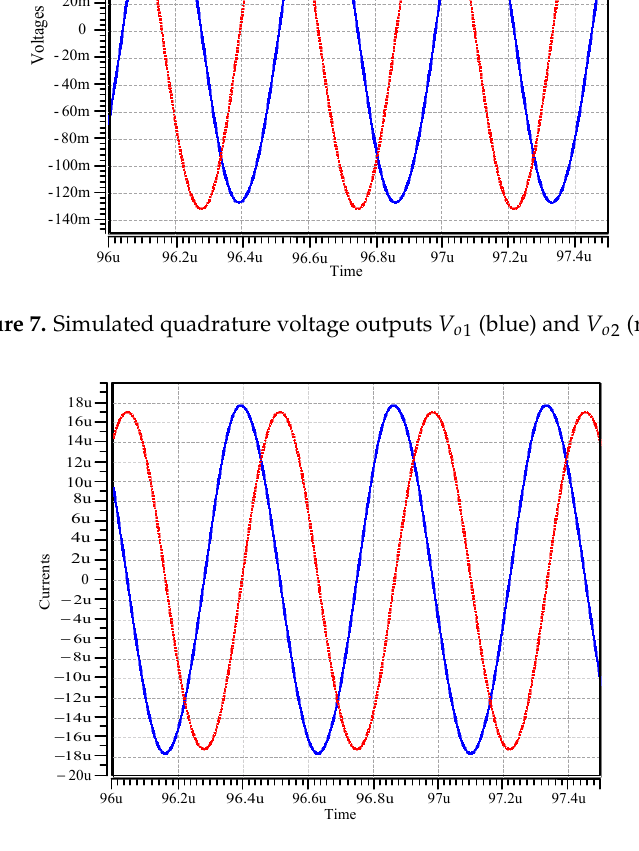
Figure 8. Simulated quadrature current outputs I o 1 (blue) and I o 2 (red). Appl. Sci. 2016 , 6 , 179